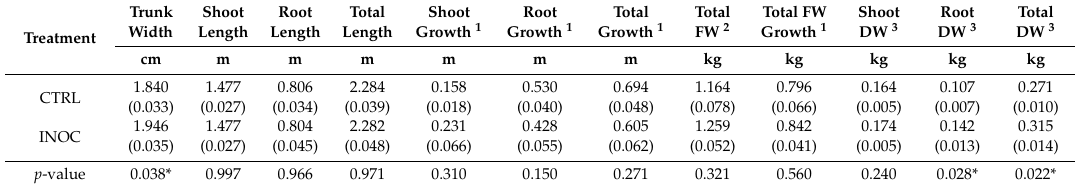
Figure 4. Time course responses of chlorophyll characteristics of the apple tree leaves: ( a ) chlorophyll content; ( b ) chlorophyll fluorescence. Points indicate the means of the replicated samples from each treatment group ( n = 13-15, CTRL and INOC for mock-inoculated control and endophyte-inoculated group, respectively). Error bars represent the standard errors of the means (** p = 0.001). Table 3. Biomass characteristics of apple trees at harvest: The means of responses are provided with the standard errors of the means in parentheses (CTRL, mock-inoculated control; INOC, endophyte-inoculated; n = 15). p -values of an unpaired two sample t -test results on each parameter are provided with significance codes of *, **, and *** for < 0.05, 0.01, and 0.001,